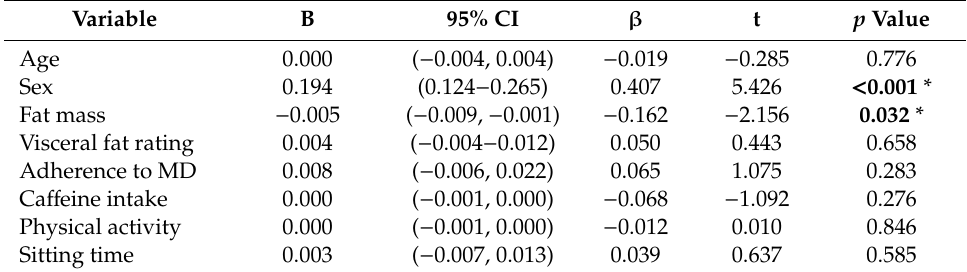
Table 8. Multiple linear regression for adiponectin.